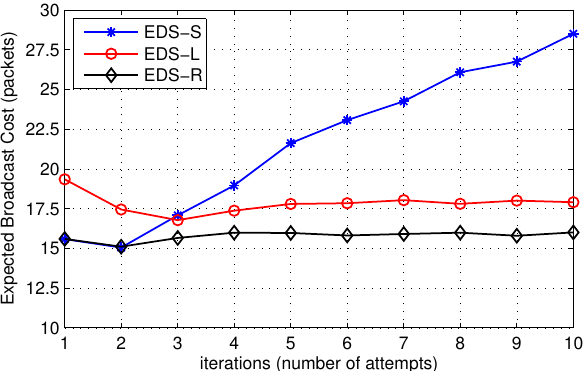
Figure 16. Effect on expected broadcast cost for different TTL choices.